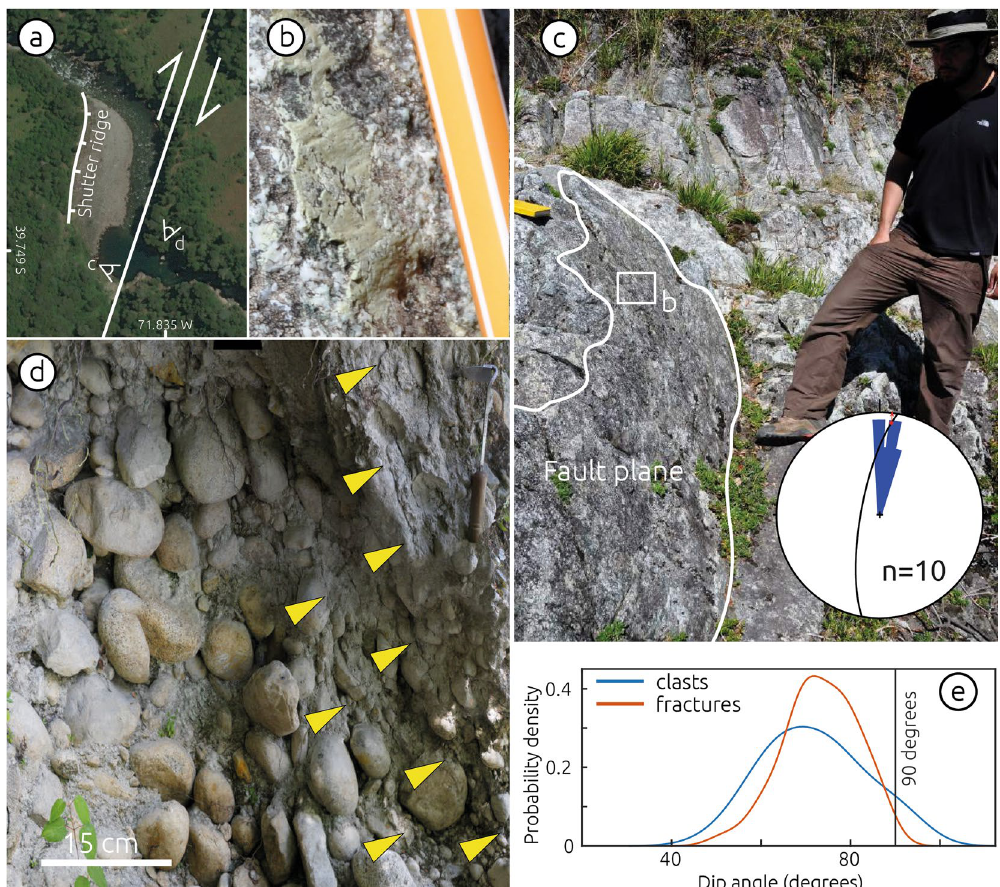
Figure 5. Field evidence of strike-slip faulting at the Liquiñe Site. ( a ) Satellite image showing location of field views in panels ( b ), ( c ) and ( d ), as well as trace of the Liquiñe Fault and extent of shutter ridge. ( b ) Detailed view of subhorizontal slickenside in fault plane shown in ( c ). ( c ) Fault planes affecting granitic bedrock. Rose diagram shows distribution of fault strike measurements (n = 10), constructed using Stereonet v. 11 (http://www. geo.corne ll.edu/geolo gy/facul ty/RWA/progr ams/stere onet.html). Black circle and red arrow show stereographic projection of the fault plane and slickenside lineation shown in b, constructed using FaultKin v. 8 (http://www. geo.corne ll.edu/geolo gy/facul ty/RWA/progr ams/fault kin.html). ( d ) Field view looking north of shear zone affecting conglomerates of terrace T2. Yellow arrows show trans-granular fractures affecting matrix and clasts. ( e ) Probability density functions of fractures and rotated clasts dips within the shear zone in ( c ). Probability density functions calculated using 64 and 39 measurements of clast long axes and fractures, respectively, from east to west, using MATLAB R2017a (www.mathw orks.com). Figure drafted using Inkscape 1.0 (www.inksc ape. com). Photos reproduced with consent from copyright